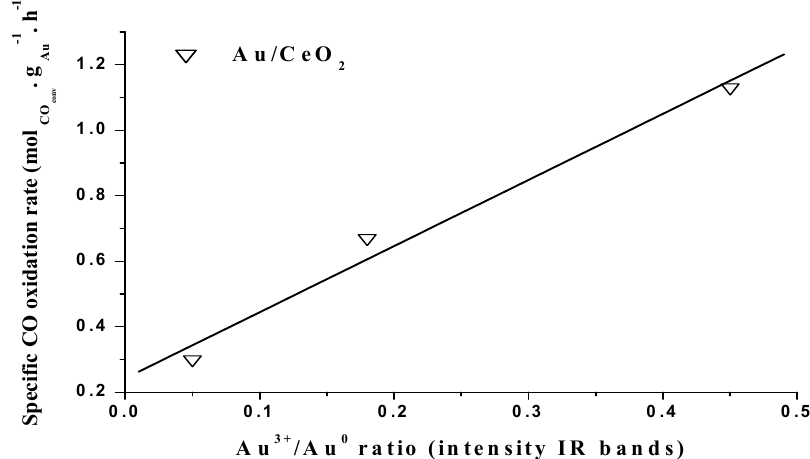
Figure 2. Correlation between Au 3+ /Au 0 species and specific rate for CO oxidation catalyzed by gold supported on nanocrystalline ceria. Adapted from Guzman et al. [128].